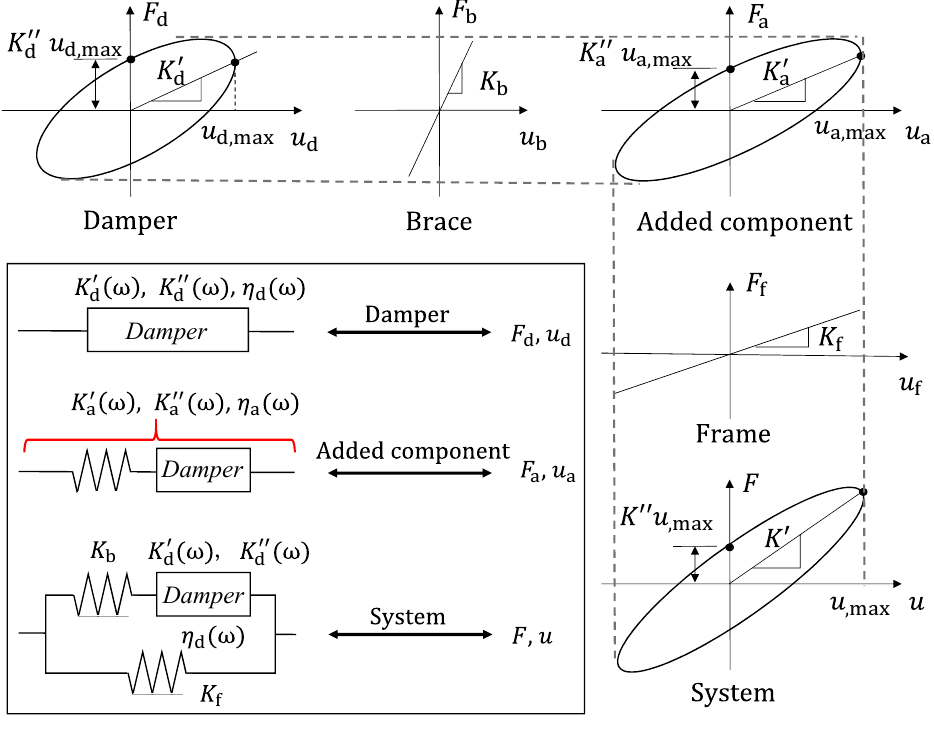
Figure 4. VE system and its hysteresis loops